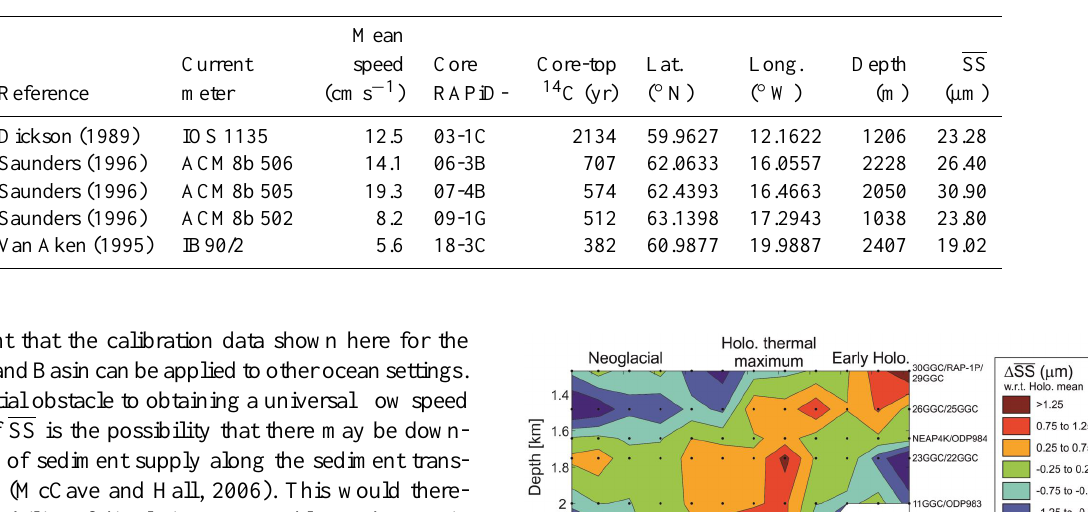
Table 1. Core-top SS calibration data, determined using a Sedigraph. Core-top 14 C ages (un-calibrated, no reservoir correction; Kristjans- dottir et al., 2011).